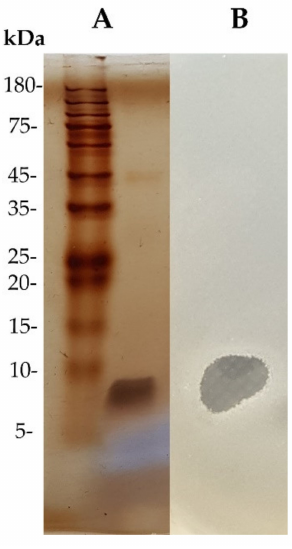
Figure 5. SDS-PAGE and gel overlay assay of the purified substance from WUL10. ( A ) The silver- stained gel of WUL10 substance after reversed-phase chromatography compared with protein marker. ( B ) The gel was overlaid with soft agar containing S. aureus TISTR 517, showing the inhibition zone at the same